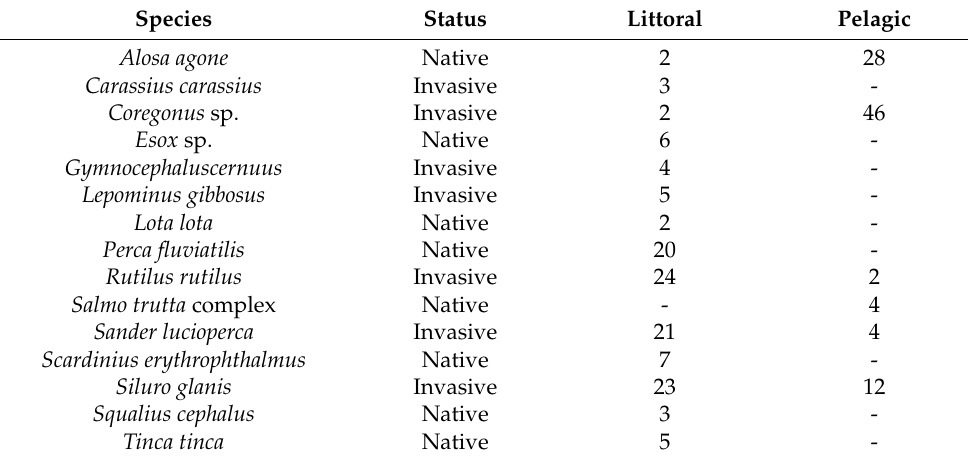
Table 2. Littoral and pelagic fish community description. Species found during sampling, its native or invasive status, and number of sampling occasions the species were retrieved in each environment (cf. Supplementary Tables